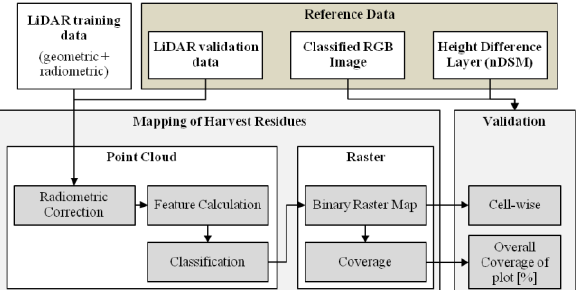
Figure 1. Workflow to map harvest residues using full- waveform point cloud and raster